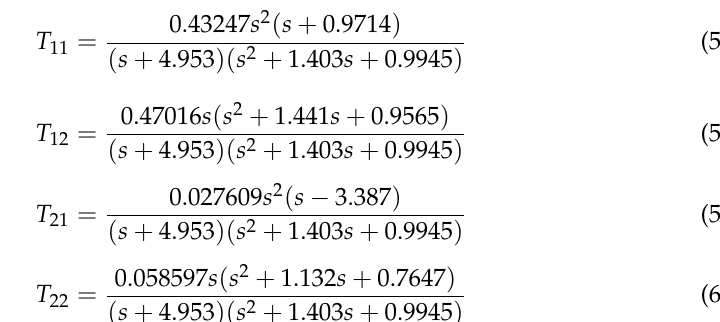
of the specific force in the blue line was smaller.